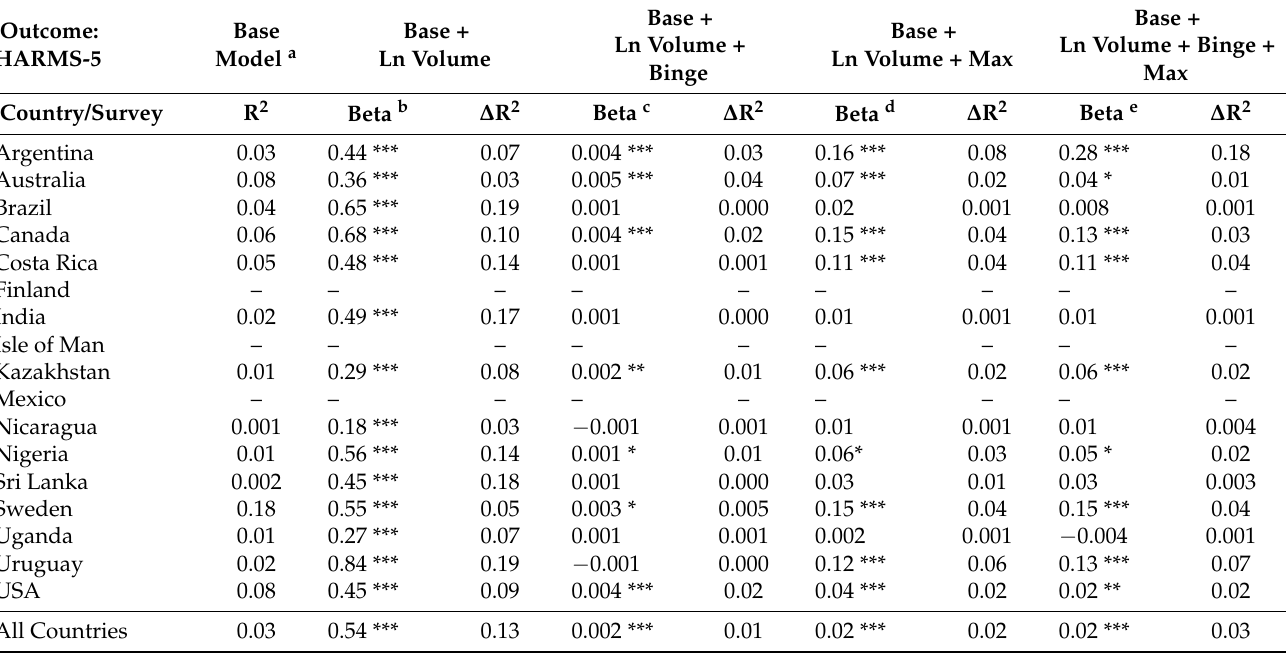
Table 5. Male Regressions Predicting HARMS-5.